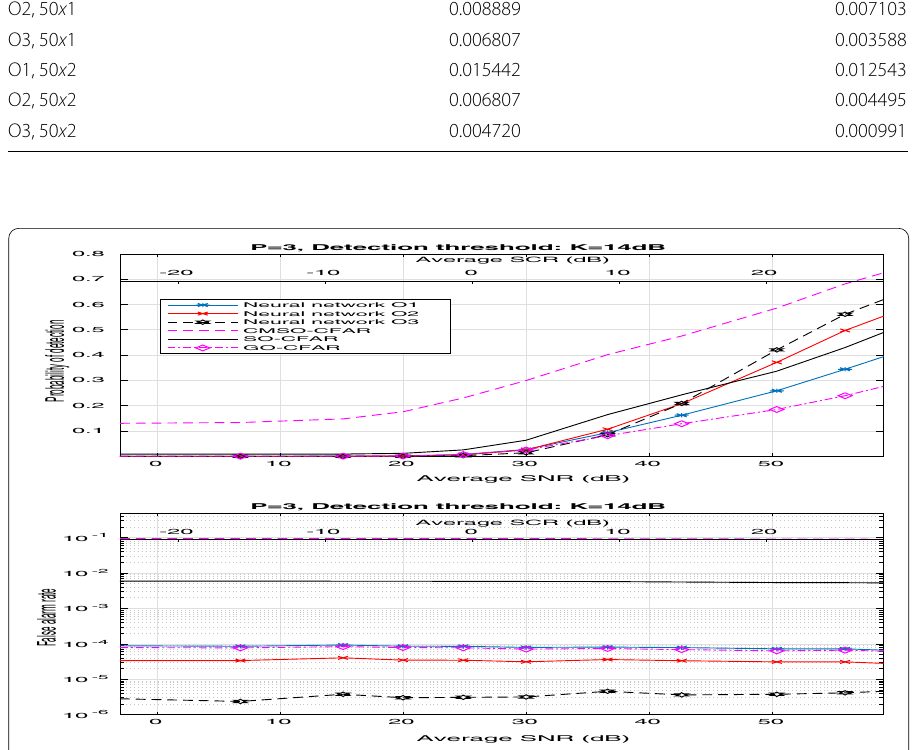
Fig. 8 P D and P FA , Clutter and noise scenario, 50 x 1 network, P =